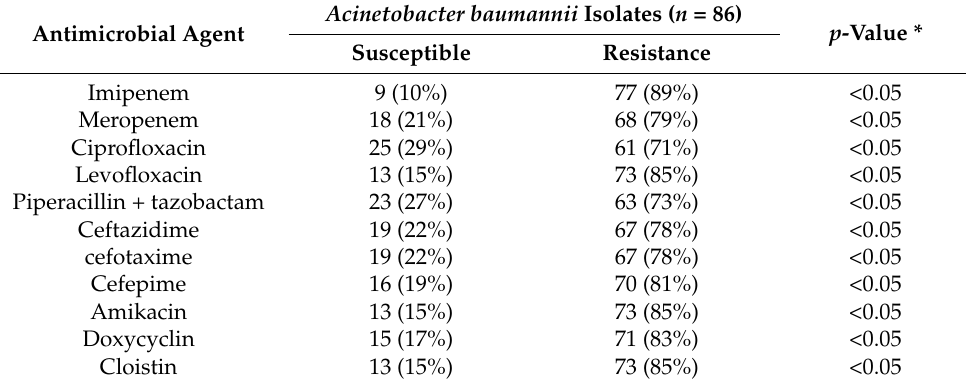
Table 1. Comparison of drug resistance patterns of 86 Acinetobacter baumanni isolates against antimi- crobial